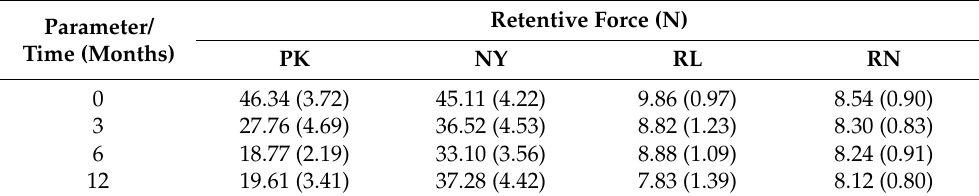
Table 2. Mean and SD of retentive force (N) of the tested groups at 0, 3, 6, and 12 months artificial aging.